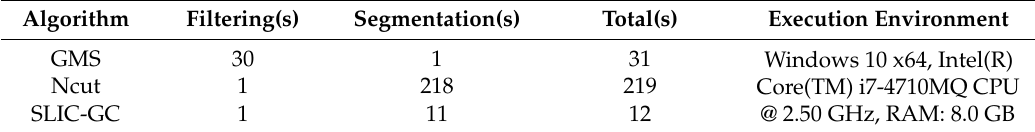
Table 2. Execution times of the different superpixel segmentation algorithms with the AirSAR